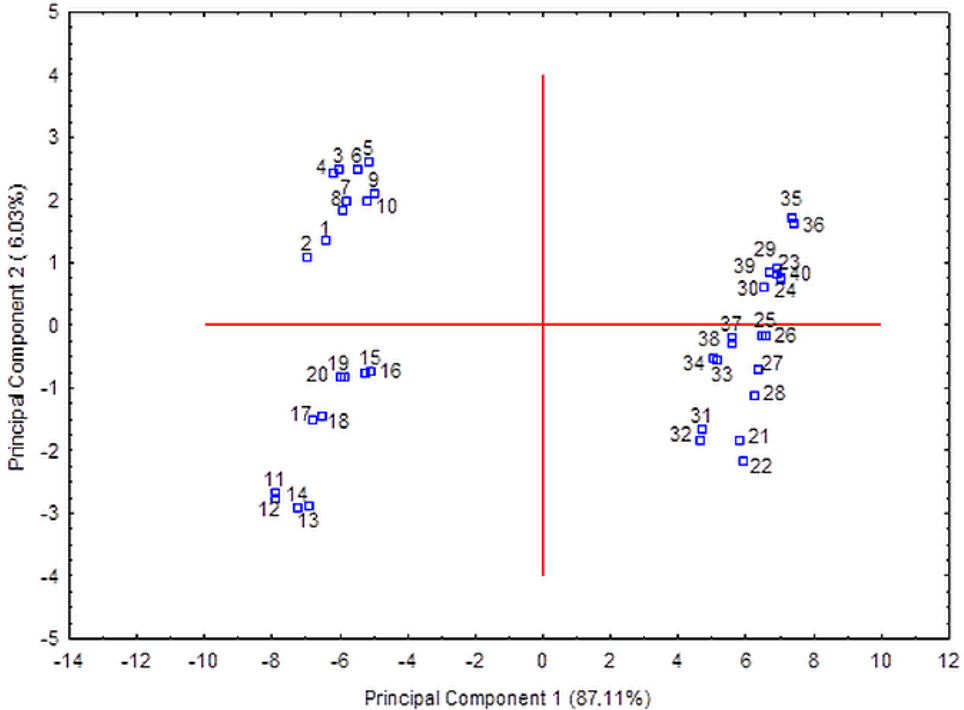
Figure 4. Score plot of wine samples on the PCA plane defined by the first two principal components (R1-R5 wines: 1–10, R1 LAB–R5 LAB wines: 11–20, Z1-Z5 wines: 21–30, Z1 LAB–Z5 LAB wines: 31–40; see Table 1 for phenolic compounds names) .